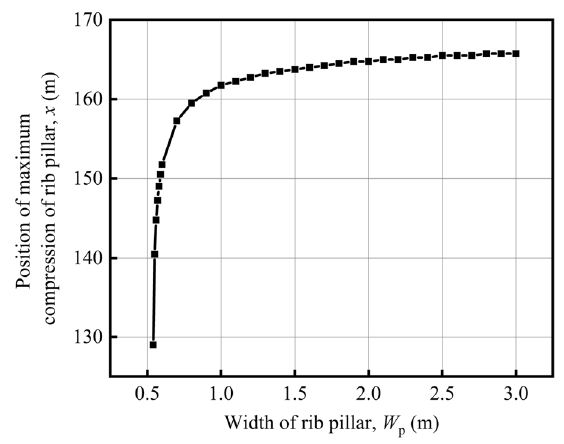
Fig. 13 Position of the maximum compression of the rib pillar